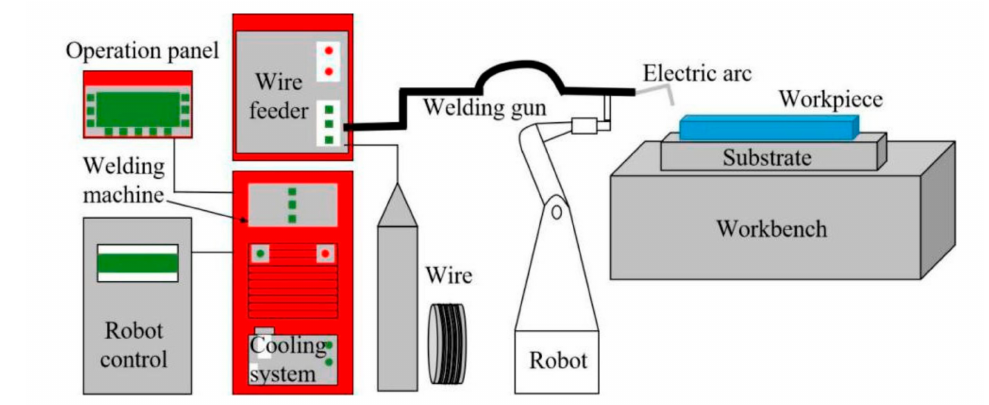
Figure 1. The schematic diagram of WAAM-CMT